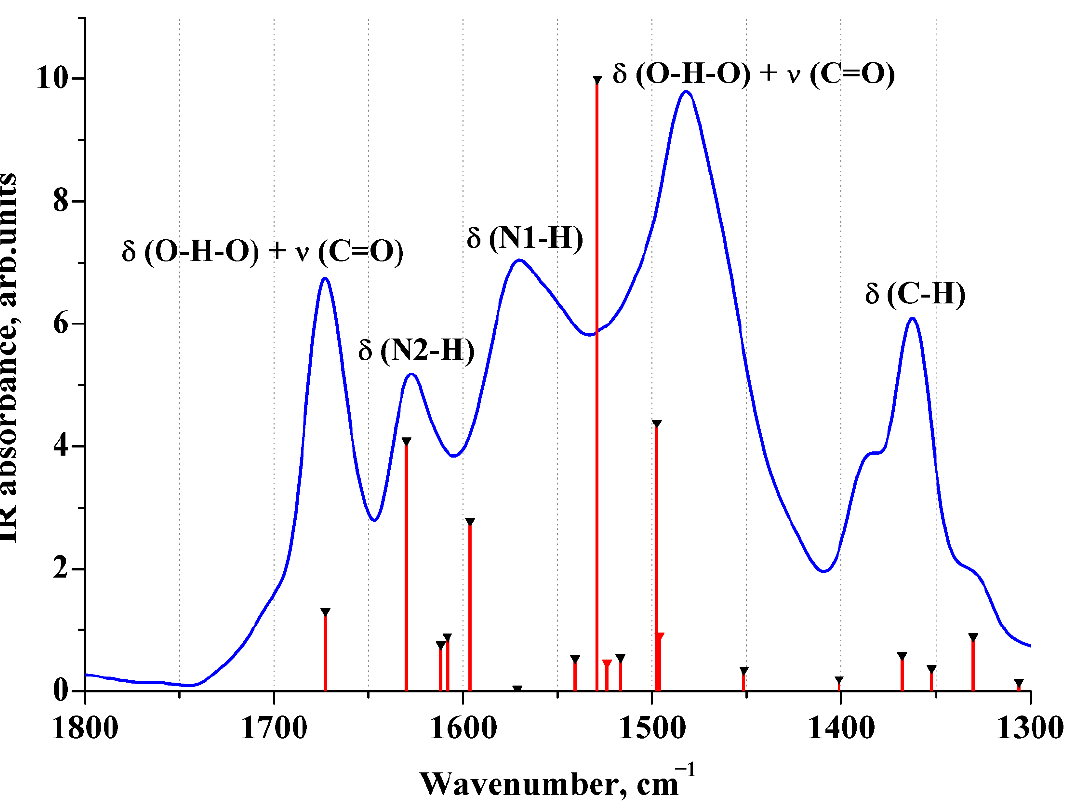
Figure 8. Experimental ATR IR spectra of aqueous solution of [2AmPyr + Mle] in the range of 1800–1300 cm − 1 . The calculated vibrations are given by sticks. Their height is proportional to the theoretical IR intensity. δ denotes in-plane bending vibrations, ν –stretching vibrations.